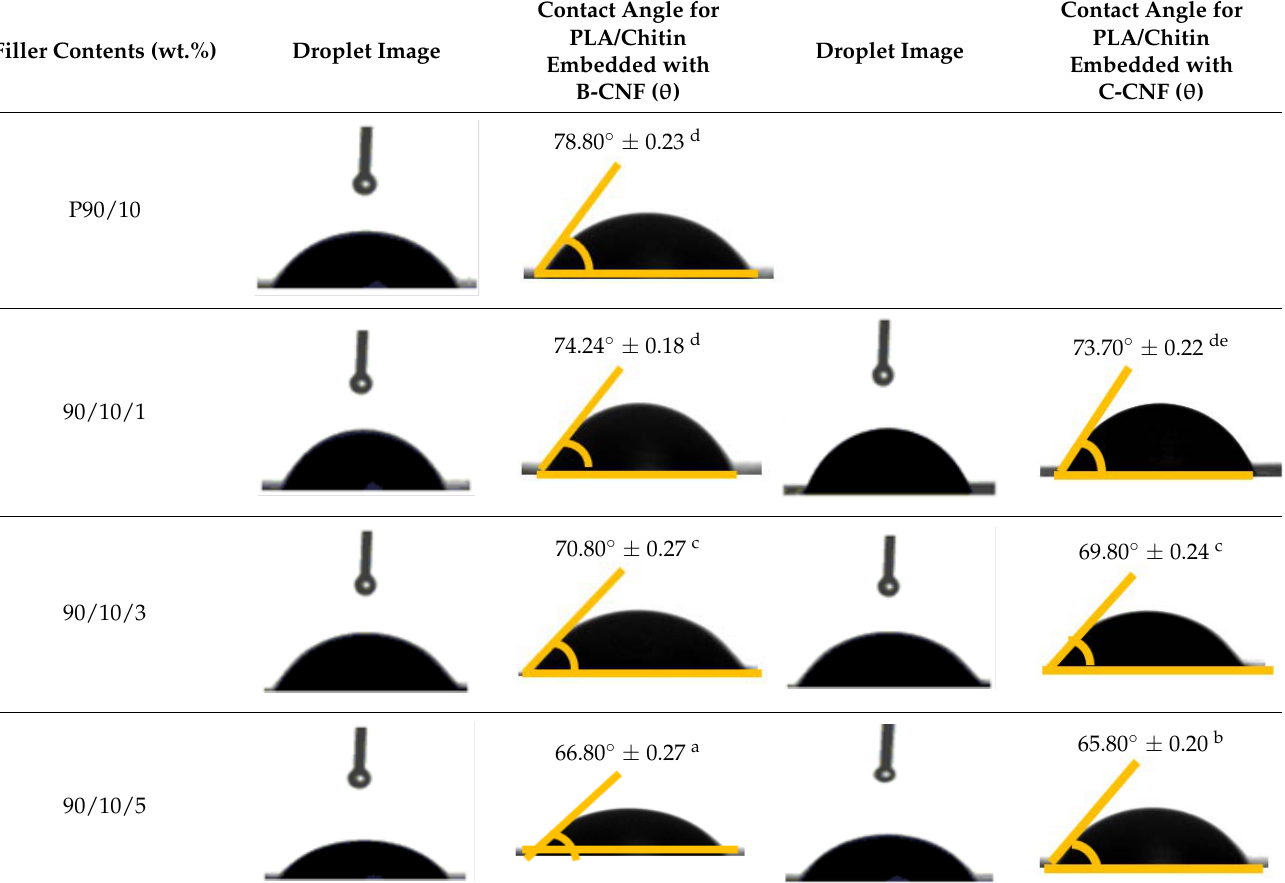
Table 1. Contact angles of bamboo and commercial CNF biocomposites.